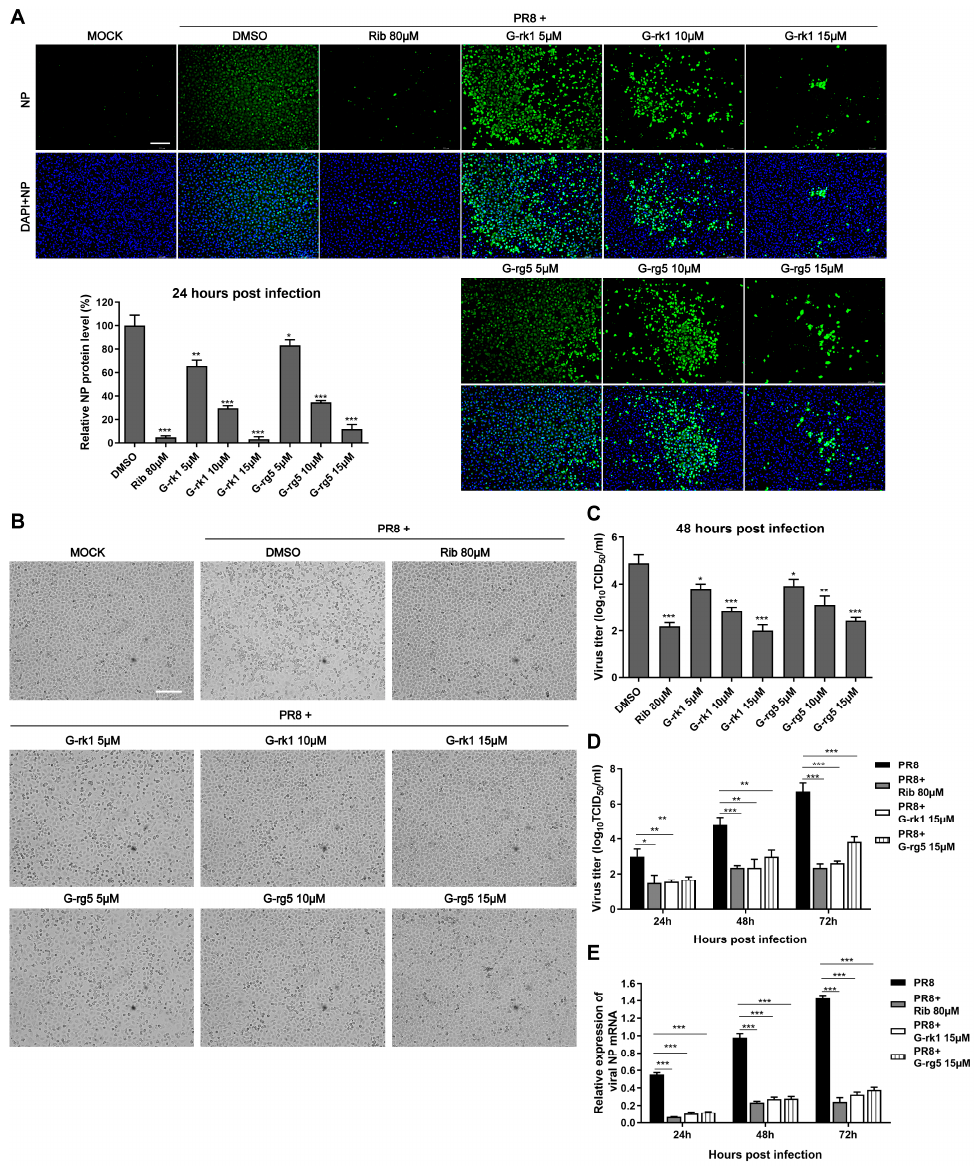
Figure 2. G-rk1 and G-rg5 inhibit PR8 influenza virus infection in A549 cells. Cells were cultivated in fresh media containing various concentrations of the relevant substance after being infected with PR8 (0.1 MOI) for 2 h at 37 °C. ( A ) Inhibition of G-rk1 and G-rg5 on PR8 replication in A549 cells by IFA at 24 hpi. Representative IFA images from one of the three independent experiments are displayed. The scale bar represents 250 µ m. Based on the relative green fluorescence intensity of compound-treated cells to the virus control cells (DMSO), the results in the bar graphs represent normalized NP protein levels. ( B , C ) After being exposed to the compounds for 48 h, the cytopathic effect (CPE) was observed under a microscope (scale bar: 250 µ m) ( B ) or the viral titer of each well including the cells and the supernatant was assessed using the endpoint dilution assay and expressed as log10 TCID 50 / mL ( C ). ( D , E ) After being exposed to the compounds for the specified time intervals, the viral titer of the cells and the supernatant from each well was assessed using the endpoint dilution assay ( D ) or the relative viral NP mRNA level was determined using real-time RT-PCR. GAPDH served as a loading control, while the viral control sample treated with DMSO at 48 hpi served as a treatment (parallel) control (set as 1) ( E ). Results from samples treated with compounds and controls treated with DMSO were compared. Statistical significances are denoted by * p < 0.05, ** p < 0.01, and *** p <